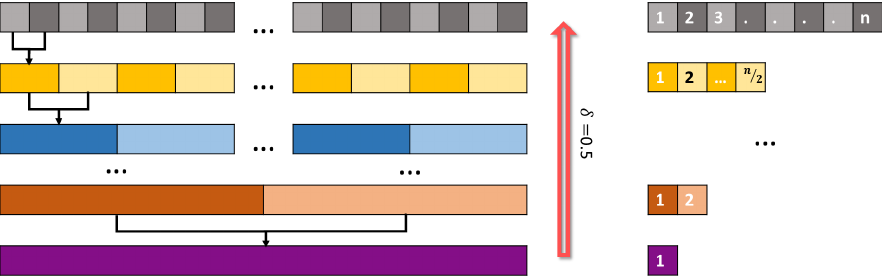
Figure 1. The schematic diagram of improving flow of A-RSE-f0 based on dichotomy